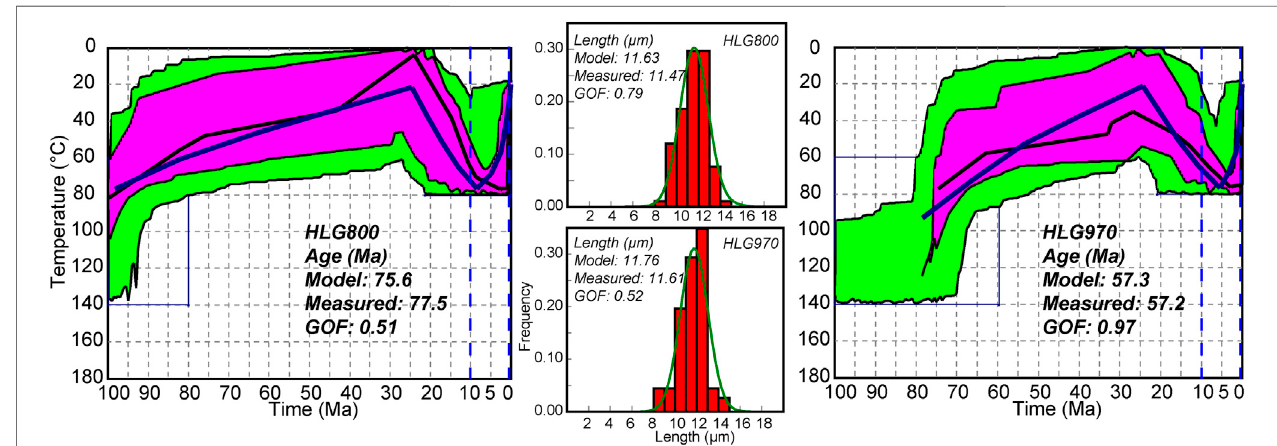
FIGURE10 | Inferred thermal histories forrepresentative samplesunder the depositional age constraintsof Wang et al. (2017). The legends are thesamewith that in Figure 8 .